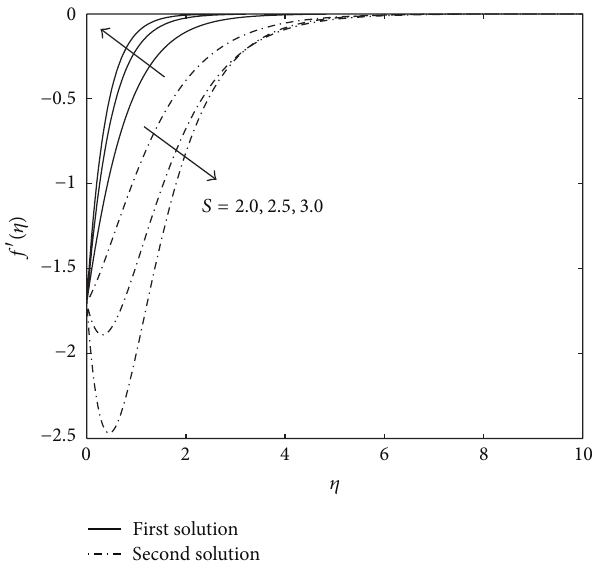
Figure 5: Velocity profiles in 𝑥 -direction for different values of 𝑆 when 𝜆 1 = −1.7 and 𝜆 2 = 1